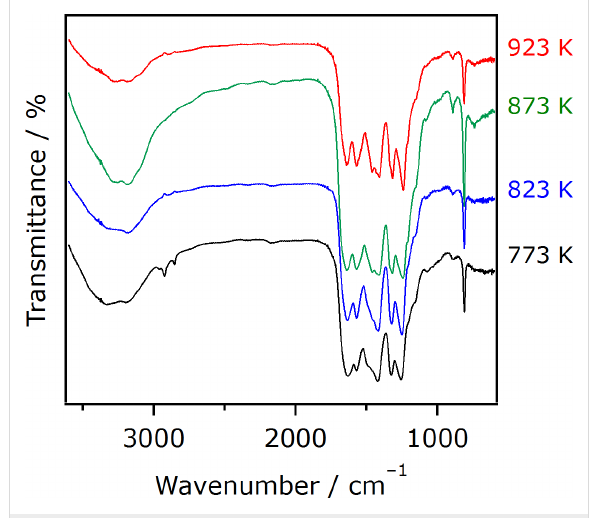
Figure 2: FTIR spectra of g-C 3 N 4 synthesized at different temperatures. Each spectrum was acquired by a KBr method in N 2